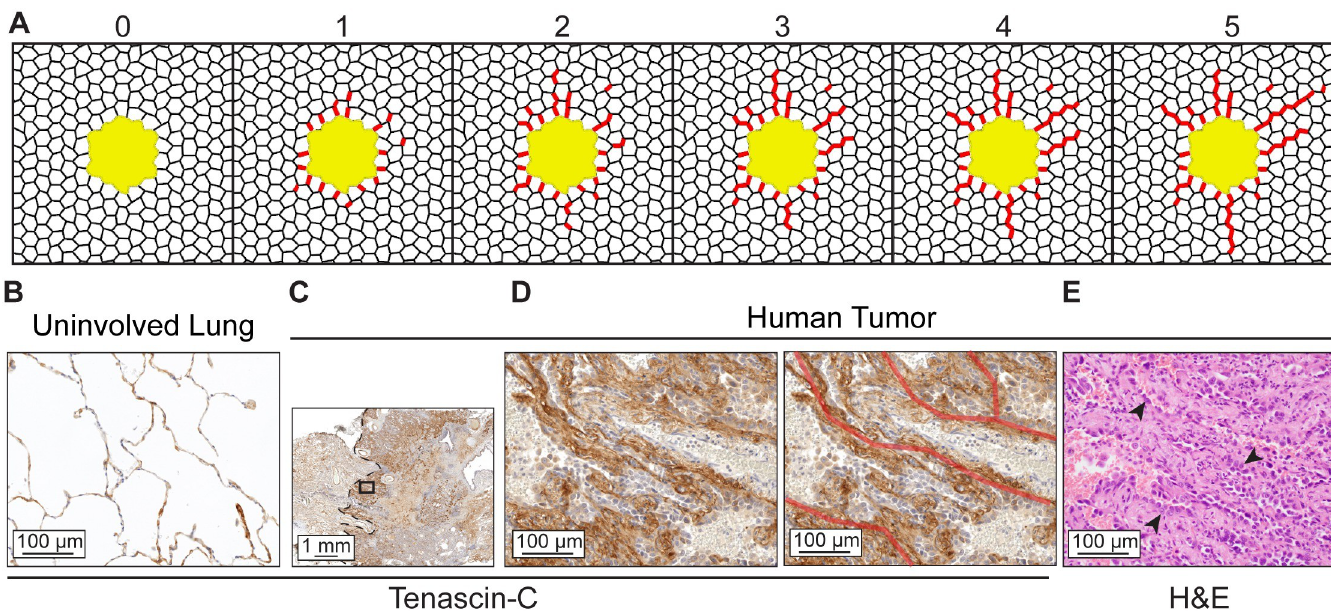
Fig 6. Strain-mediated alveolar wall thickening produces tracks that emulate ECM remodeling in human LUAD. A. Simulated thickening in alveolar wall elements that experience 28% Lagrange strain at 20% applied stretch for 5 iterations. Alveolar walls thickened to 30 μ m are represented in red. B. Tenascin-C staining of a normal human lung, representative of n = 2. C. Tenascin-C staining at the edge of a T2 human tumor, representative of n = 6 T1 and T2 tumors. Dotted line shows the tumor edge (DAB with hematoxylin, 10x magnification). D. Inset from C. shows tracks of thick, Tenascin-C-stained alveolar walls that extend out from the tumor (40x magnification). Red lines mark the tracks of Tenascin-C. E. Serial section from C. (H&E, 40x magnification). Arrowheads indicate tumor cells with enlarged nuclei residing on thickened tracks.